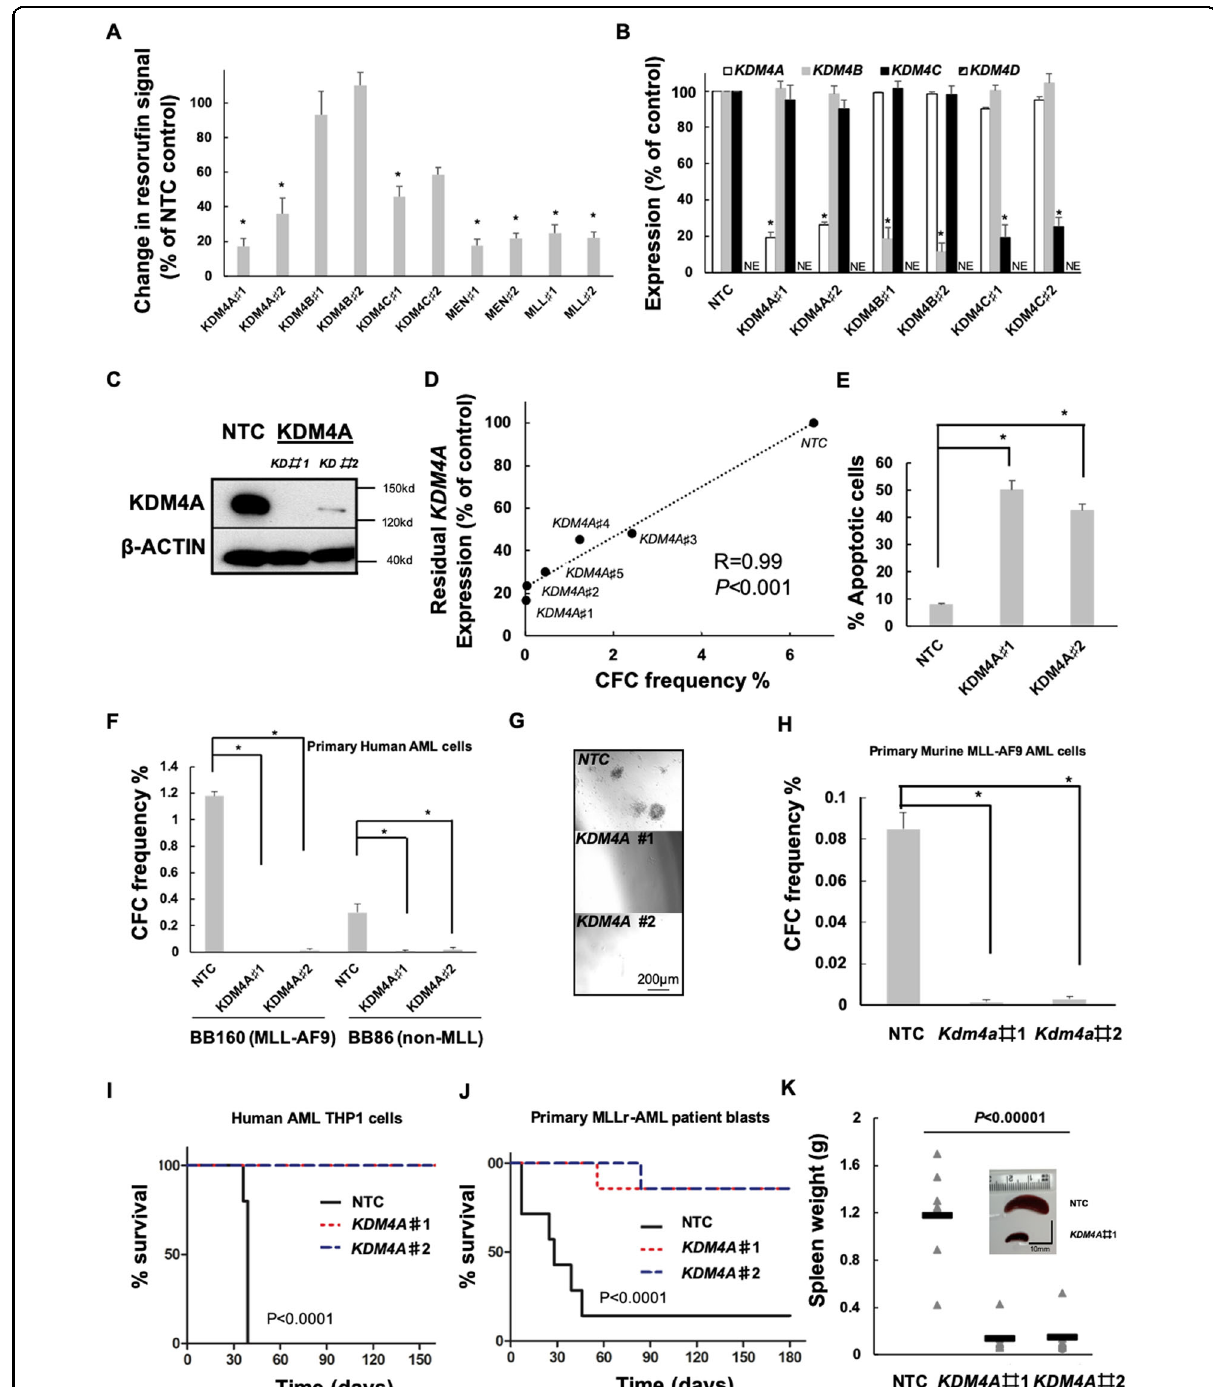
Fig. 1 (See legend on next